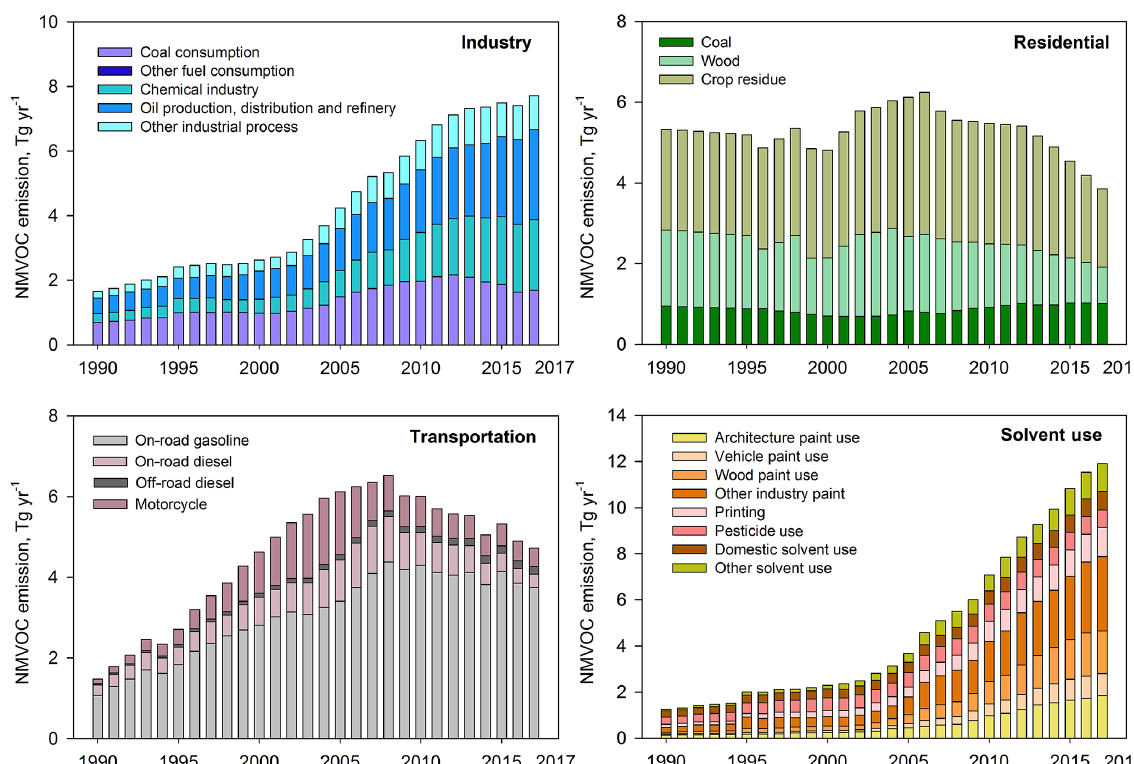
Figure 2. NMVOC emissions by subcategories of industry, residential, transportation and solvent use sector in China from 1990 to 2017.